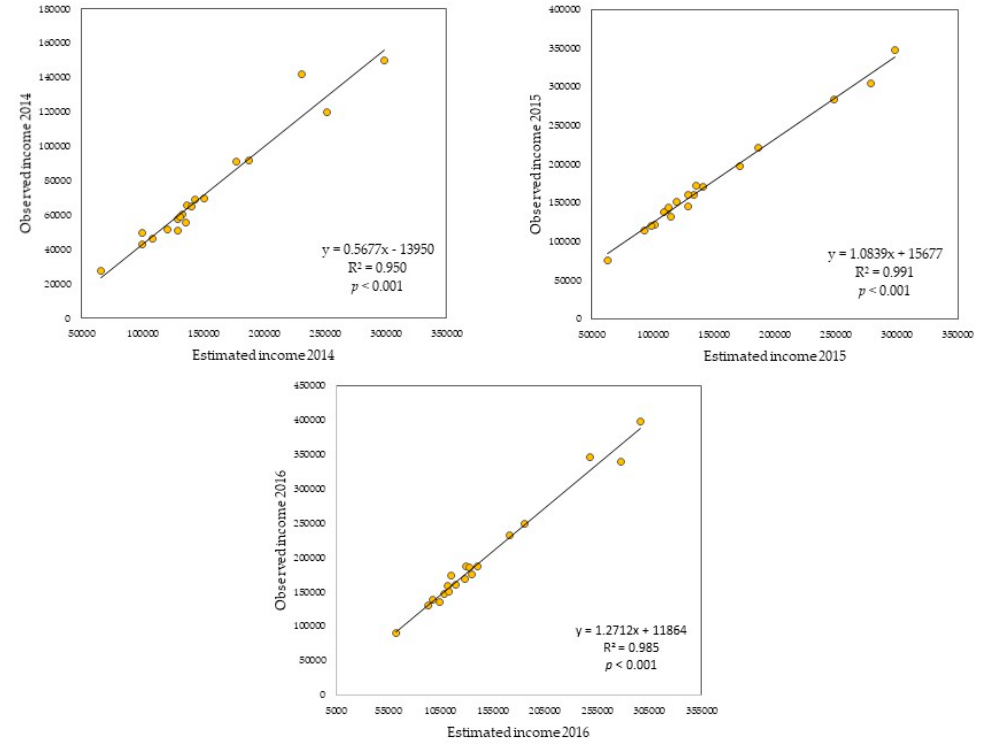
Figure 6. Linear regression model between observed and estimated income (Hungary). Table 3. The regression parameters after error reduction (Hungary).